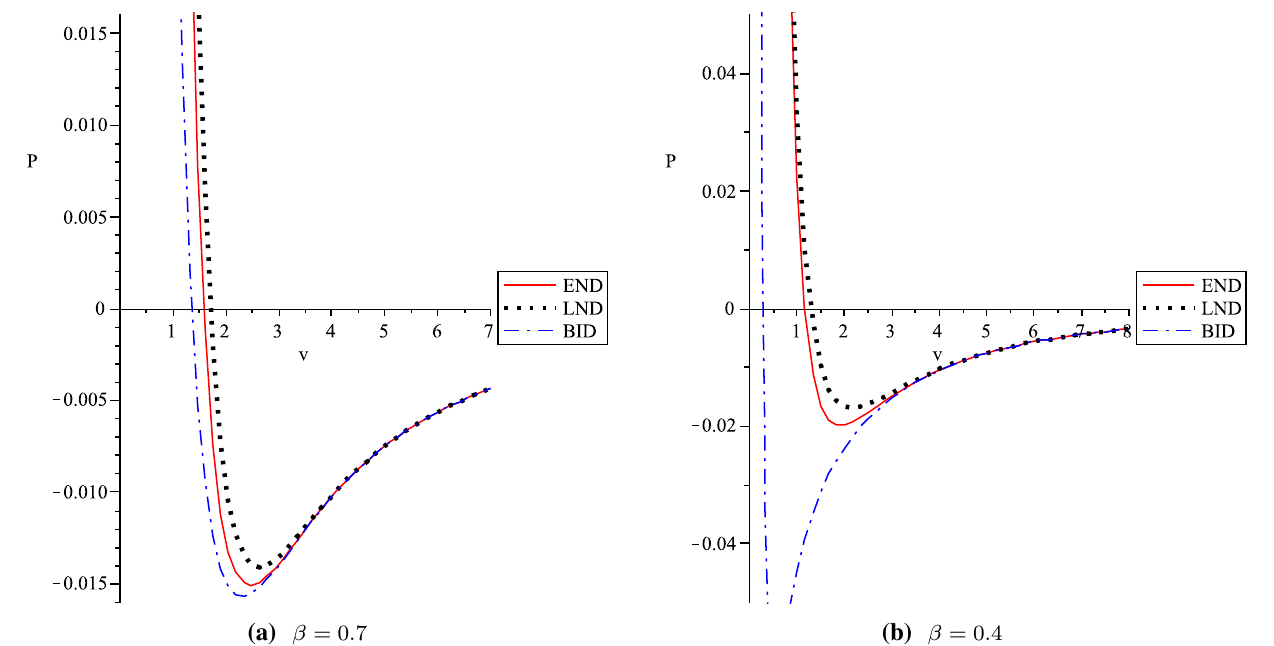
Fig. 9 P – v diagram of dilaton black holes in the same temperature T = 0 . 001 and different β . Here we have fixed α = 0 . 3 and q = b = k =